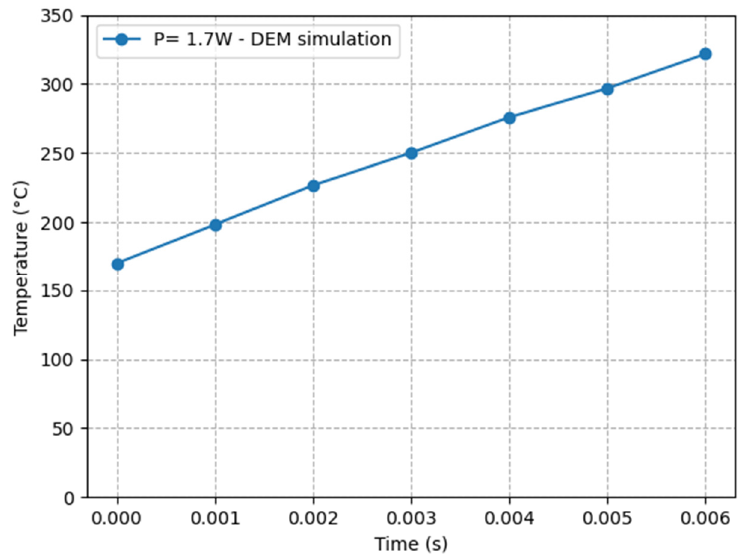
Figure 10. The temperature evolution at the center of the laser beam in our DEM simulations with